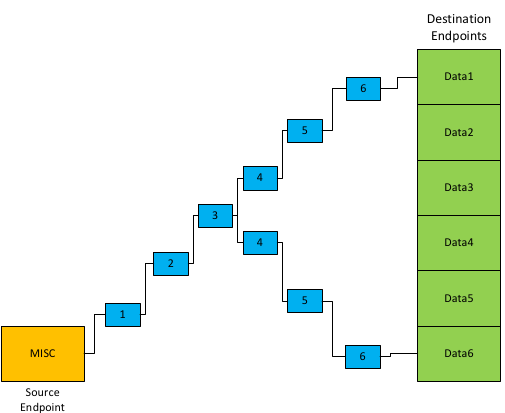
Figure 5. Tree Optimizer Phase 2 Phase 3